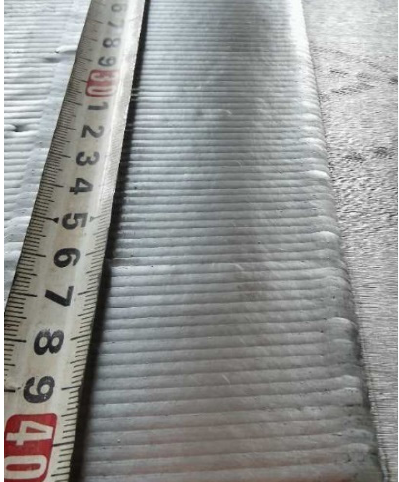
Figure 6. Appearance of first batch of laser weld overlay.